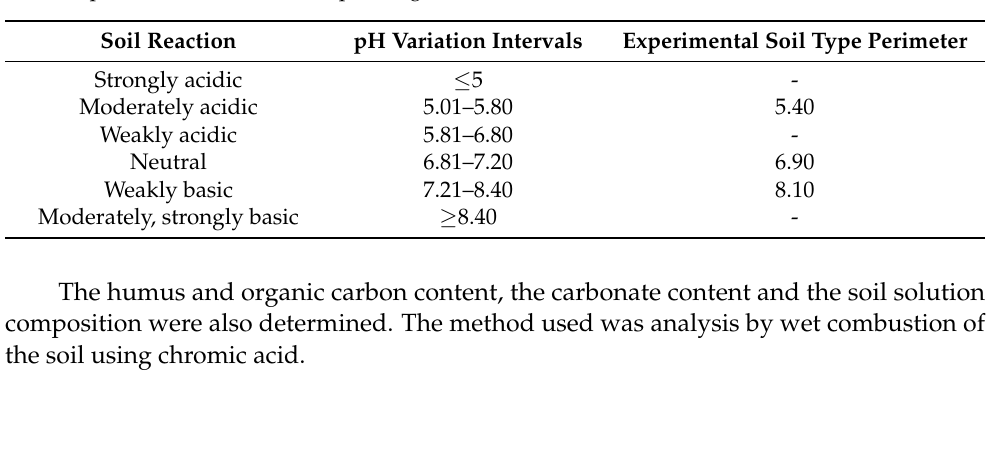
Table 1. pH variation intervals depending on soil